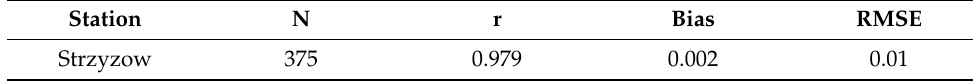
Table 1. Summary statistics: Poland–AOD vs. AERONET